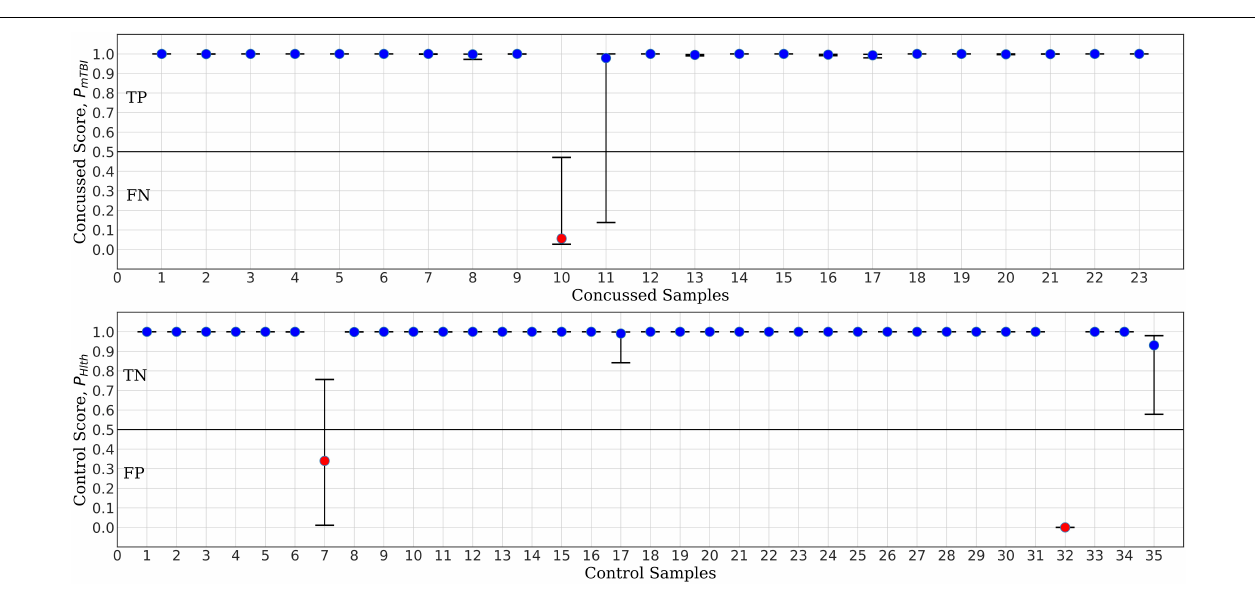
Frontiers in Human Neuroscience |